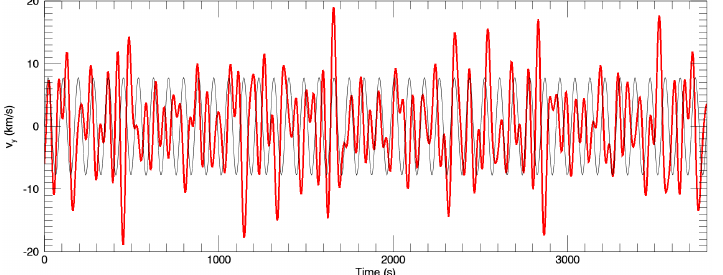
Figure 2. Wave drivers imposed at the lower z boundary for the ResUni (black) and BbUni (red) simulations. See text for